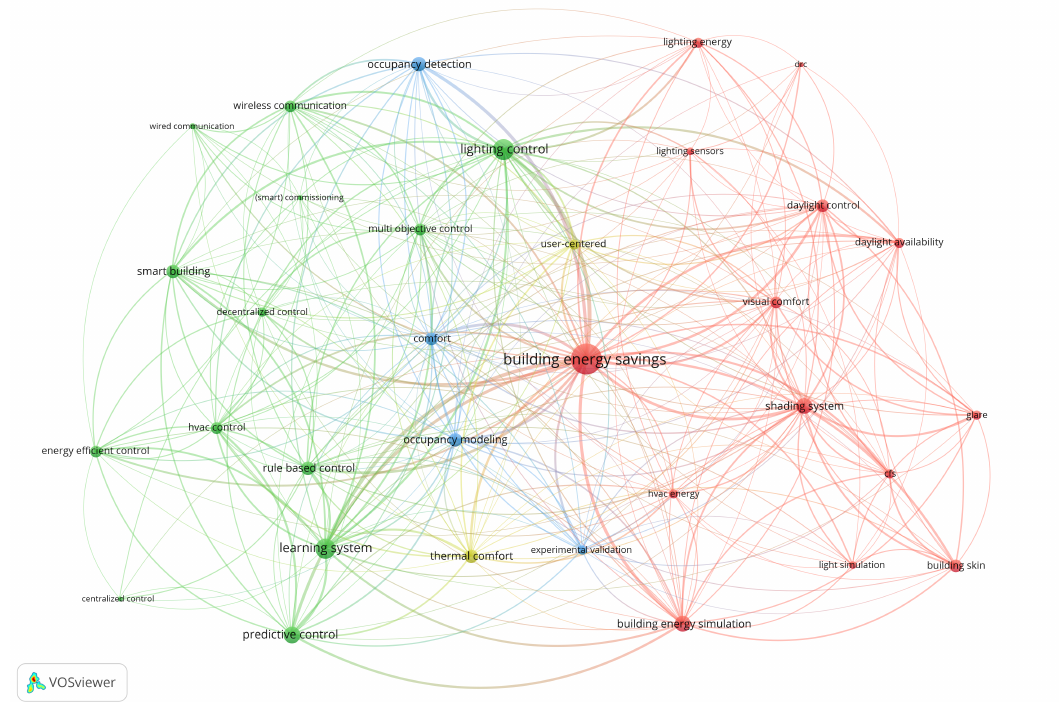
Figure 1. Network analysis of the identified research articles, classified according to the set items, visualized via